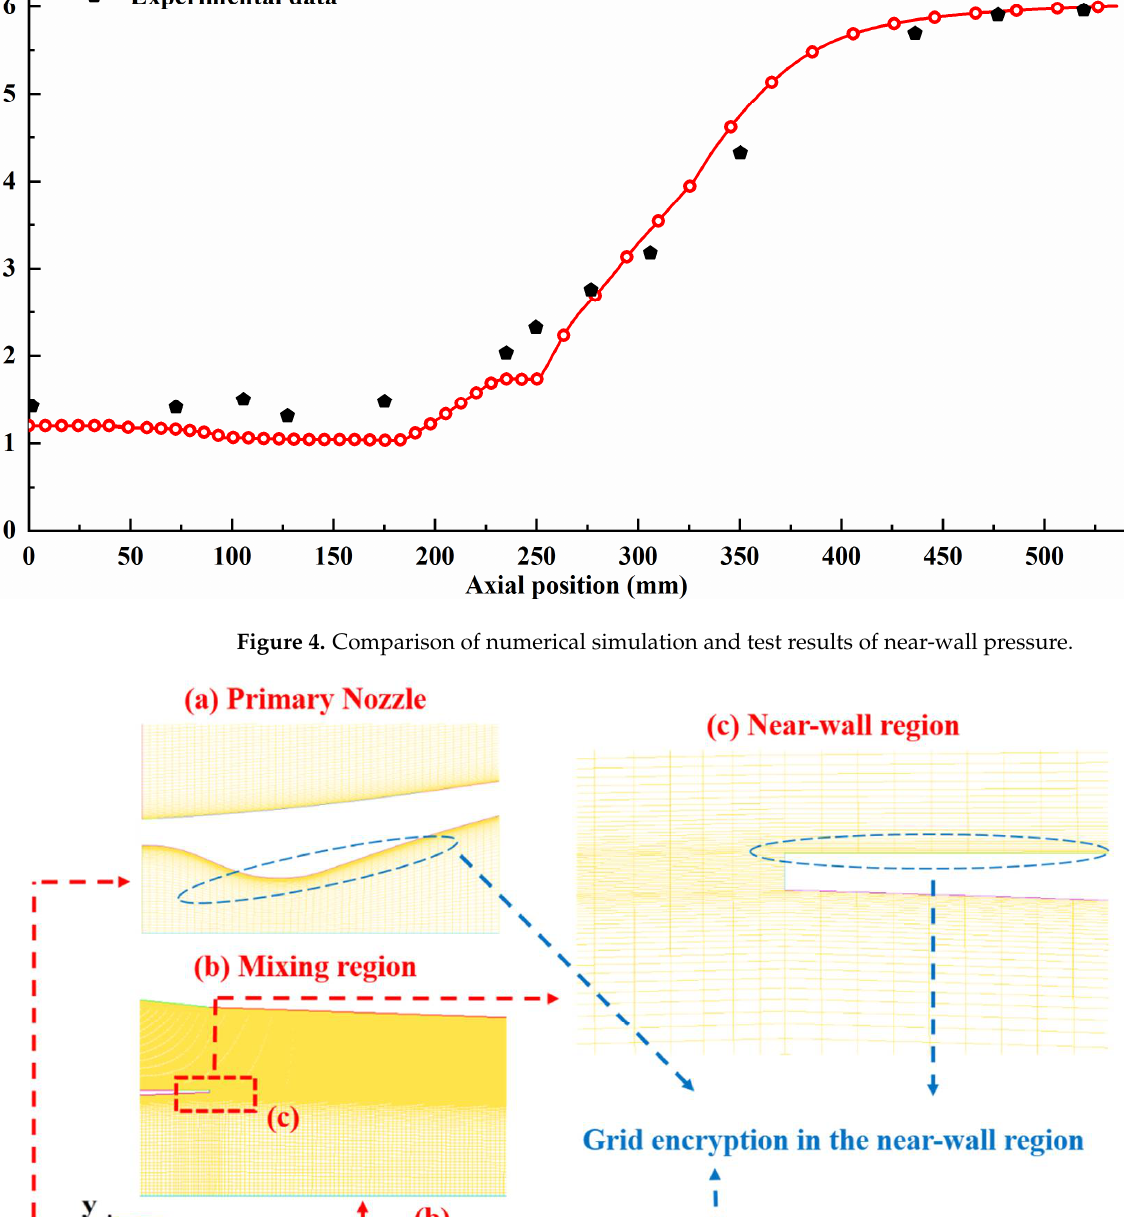
Table 3. Three-dimensional/two-dimensional model calculation results and errors.